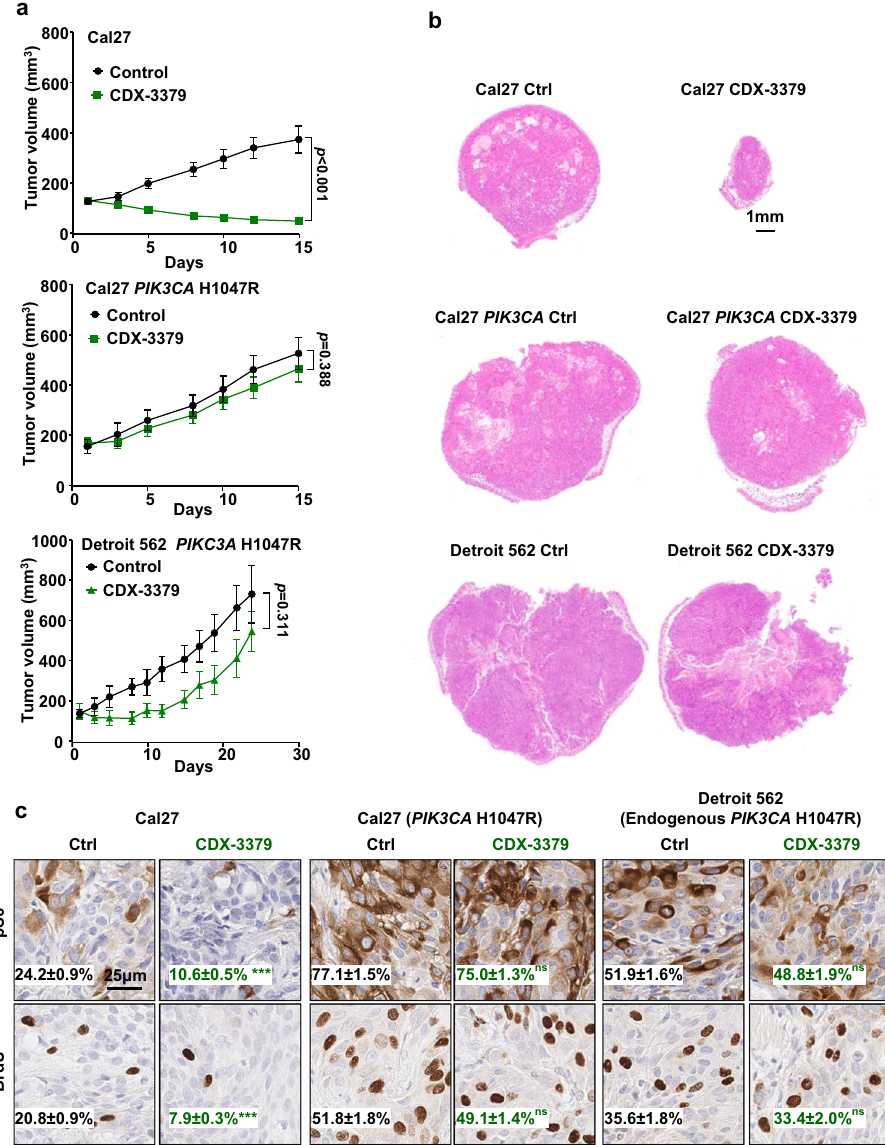
Fig. 4 Anti-tumor effect of HER3 kinase inhibition with CDX-3379 antibody in vivo. a WT Cal27 cells, Cal27 cells expressing PIK3CA H1047R or Detroit 562 were transplanted into the fl anks of athymic nude mice, and when they reached 150 – 200 mm 3 , mice were treated with vehicle diluent or CDX-3379 (10 mg/kg, three times/week) for the indicated days ( n = 10 for Cal27; n = 10 for Cal27 PIK3CA H1047R; n = 6 for Detroit 562). Data were reported as mean ± SEM; two-sided Student ’ s t -test. b Representative H&E stains of mouse tumors from the experiment from panel a . c Representative immunohistochemical analysis of pS6 and BrdU in the short-term treatment (every other day for three times) groups from panel ( a ) ( n = 4 mice per group). Brown chromogen deposition re fl ects the immunoreactivity; hematoxylin was used as a nuclear counterstain (blue). Scale bars represent 25 μ m. Quanti fi cation from images using Qupath software and the percentage of positive staining are shown on each image. Data were reported as mean ± SEM, two-sided Student ’ s t -test, p > 0.05, non-signi fi cant or ns; *** p < .001 when compared with the control-treated group. Source data are provided as a Source Data fi